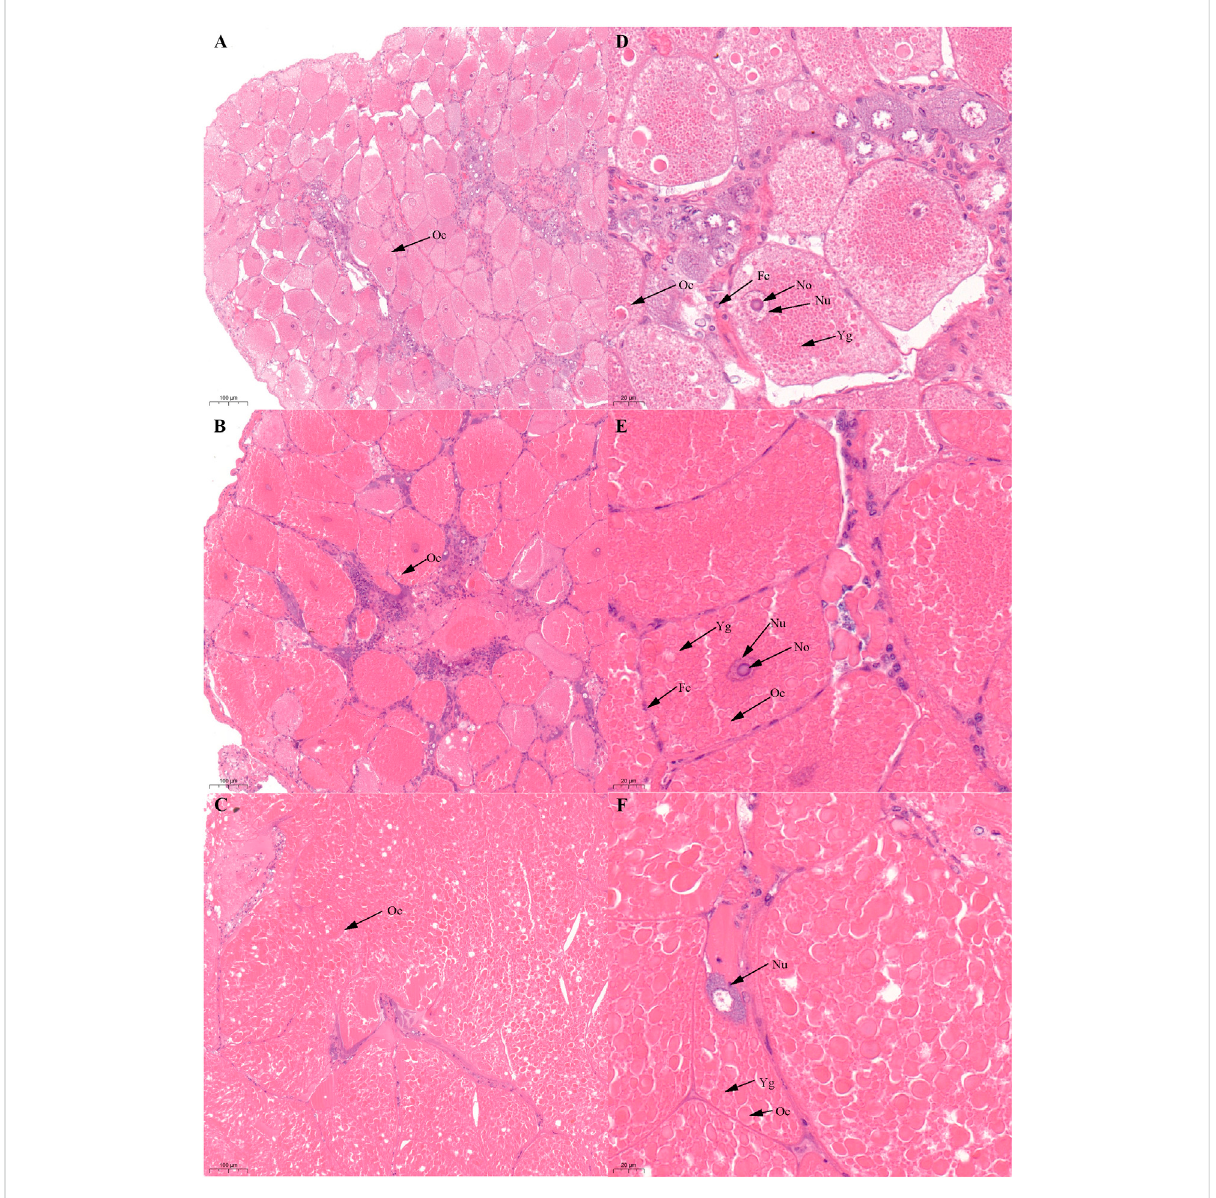
FIGURE 2 Histological characteristics in the ovary of Scylla paramamosain during the SVP. (A,D) : ovarian stage Ⅲ (S-OV-3); (B,E) : ovarian stage Ⅳ (S-OV-4); (C,F) : ovarian stage Ⅴ (S-OV-5). Oc, Oocyte; Fc, Follicular cells; Nu, Nucleus; No, Nucleolus; Yg, Yolk